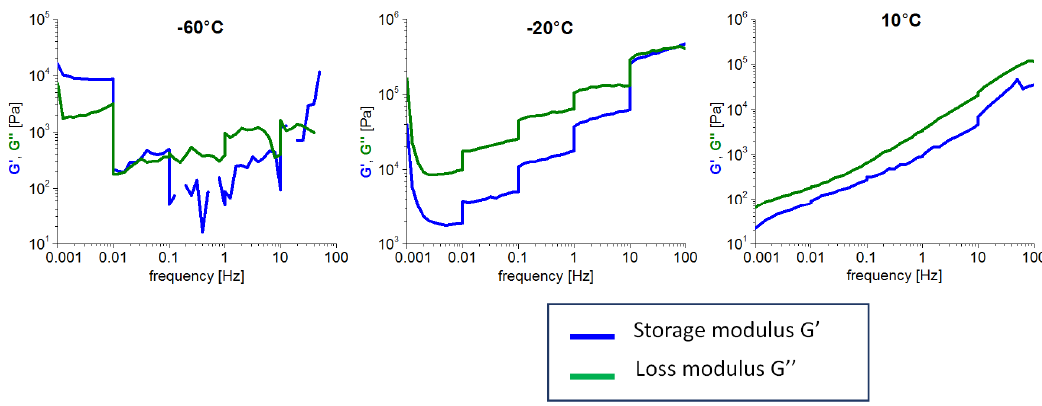
Figure 9. Frequency-stiffening of H11–BAFKU 2 observed in frequency sweep tests (1 mHz to 100 Hz) conducted at − 60 to +10 °C—selected results; the full results collection is shown in Figure S14; the strain amplitude was different in each frequency decade, ranging from 50% at 1 mHz to 1% at 100 Hz; the effect of strain-induced damage to the network, as well as of its recovery between the frequency decades is clearly visible, especially in case of G’ curves at lower temperatures.